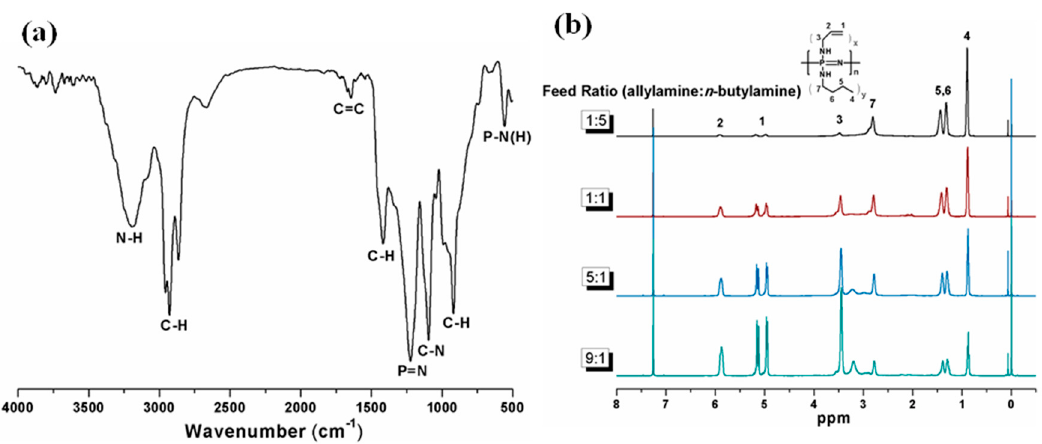
Figure 1. ( a ) FT ‐ IR; and ( b ) 1H NMR spectra of PBAP (poly( n ‐ butylamino)(allylamino)phosphazene).